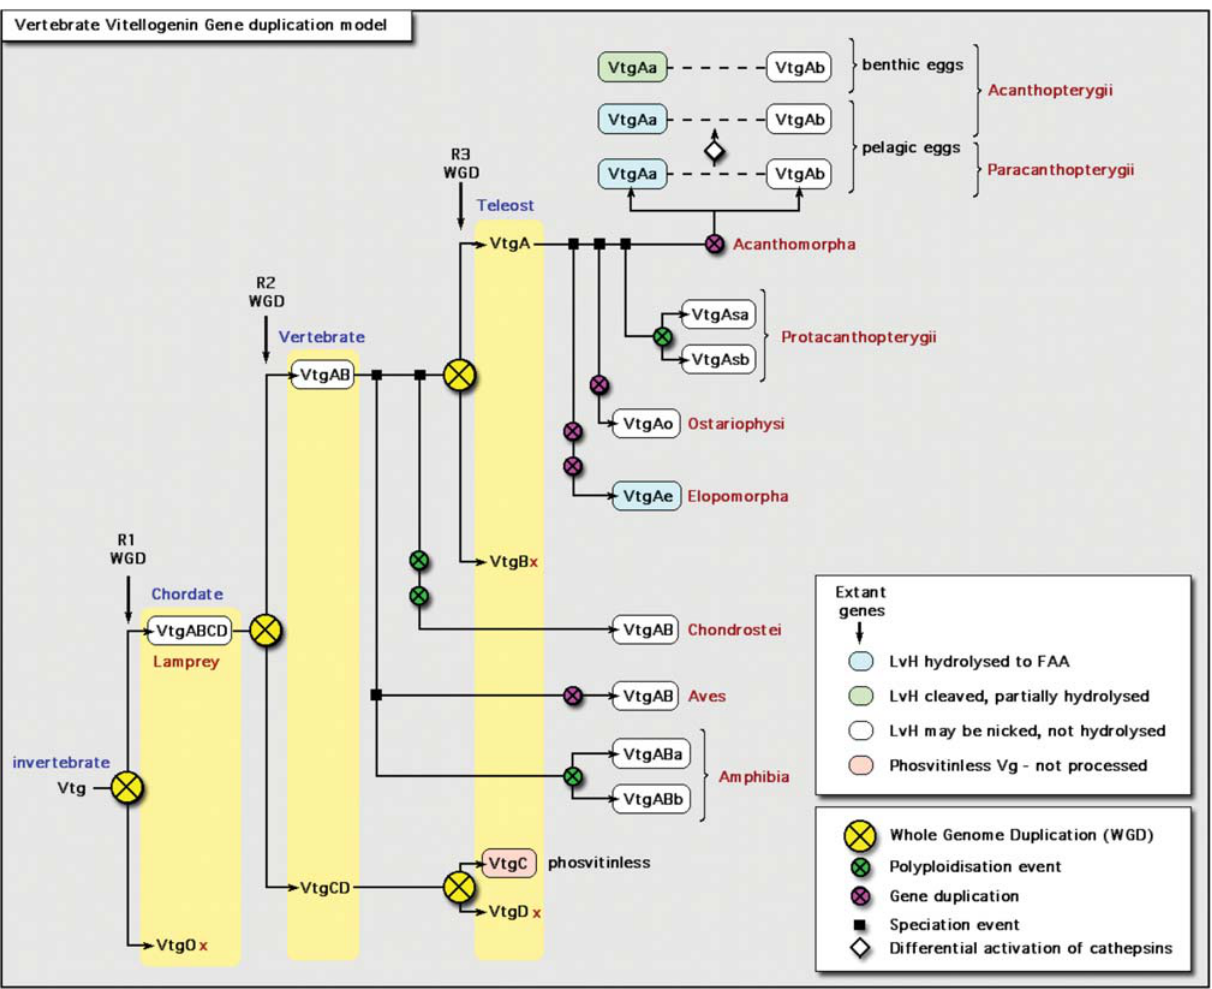
Figure 2. Proposed scheme for the classification of vertebrate vitellogenin genes based on three rounds (R1, R2, R3) of whole genome duplications (WGD), and lineage-specific gene duplications. The genes are classified according to their cluster pattern in Fig. 1 and Fig. 3 and the differential degradation of the lipovitellin heavy chain (LvH) during oocyte maturation. The loss of VtgD as is currently indicated in the scheme remains a logical conclusion since there is currently no evidence for its existence in the sequence or genome databases. Due to the low number of species examined to date, however, we do not preclude its existence. The white diamond within the acanthomorph lineage indicates differential regulation of cathepsins among pelagophils and